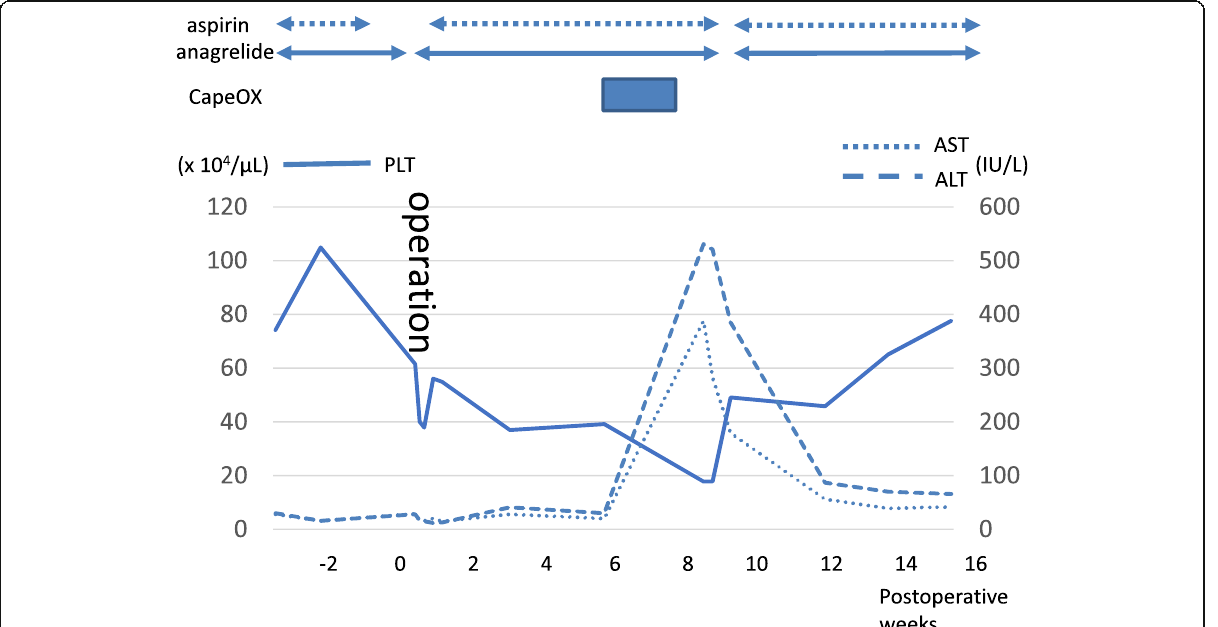
Fig. 3 Transition of platelet counts and transaminase levels from surgery to end of adjuvant chemotherapy. Anagrelide was discontinued only on the operation day and restarted on the first postoperative day. After one course of intravenous oxaliplatin plus oral capecitabine, platelets decreased and hepatic transaminase level increased. Thus, aspirin and anagrelide were discontinued; platelet count recovered to 50 × 10 4 / μ L after 5 days. She resumed internal use of anagrelide and aspirin but did not restart adjuvant chemotherapy; liver transaminase levels normalized